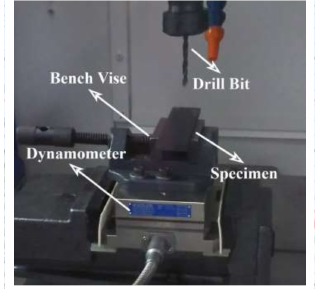
Figure 2. The drilling setup.